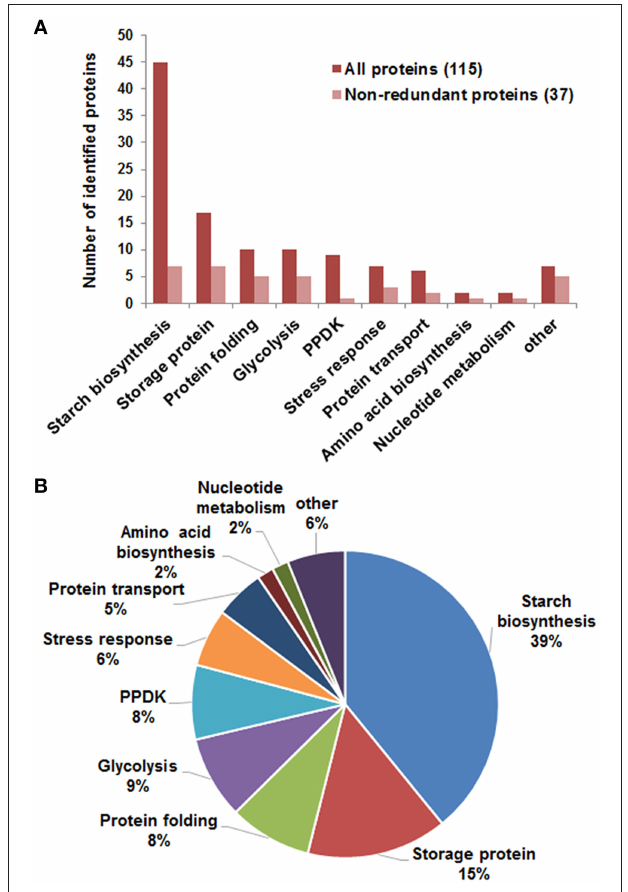
FIGURE 3 | Function categories of identified differentially expressed proteins. (A) Function classification of identified 115 proteins (red) representing 37 unipros (light red). Information involving protein identification was in Table S2, and function features in Table S6, Supporting Information. (B) Percentage of proteins in each category to the total 115 proteins.